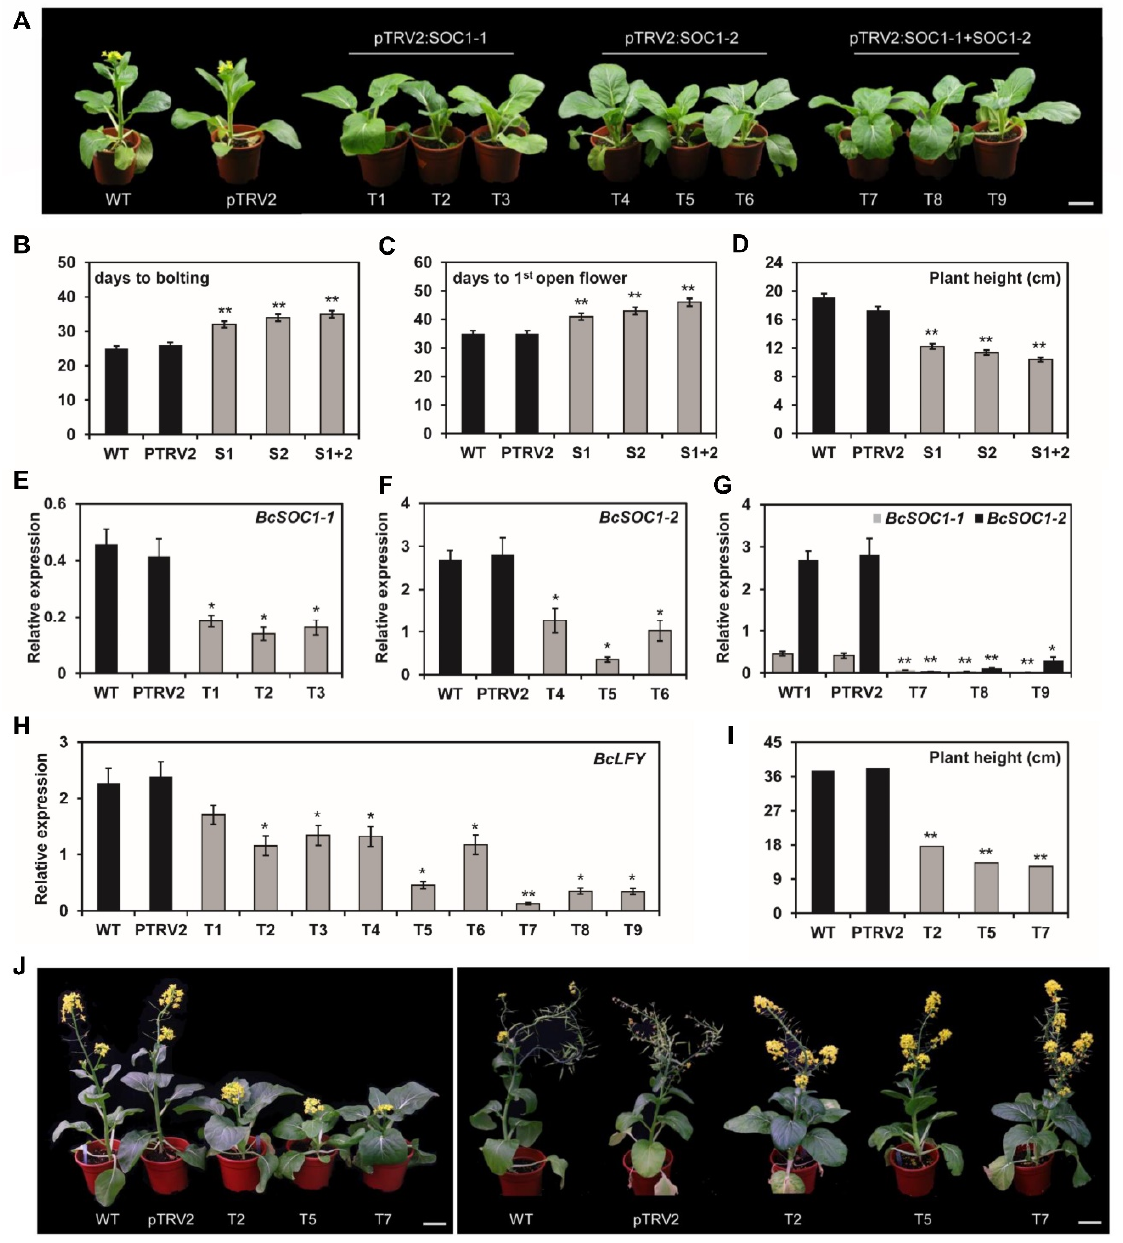
Figure 4. Knockdown of BcSOC1 using virus ‐ induced gene silencing (VIGS) in flowering Chinese cabbage. ( A ) Silencing of BcSOC1 significantly delayed bolting in flowering Chinese cabbage. S1, S2, and S1+2 represent pTRV2: SOC1 ‐ 1 , SOC1 ‐ 2 , and SOC1 ‐ 1 + SOC1 ‐ 2 , respectively. ( B – D ) Quantification of delayed bolting phenotypes in BcSOC1 knockdown lines. S1, S2 and S1+2 represent averages of the corresponding single and double knockdown lines, respectively. ( E – H ) Expression of BcSOC1 ‐ 1 , BcSOC1 ‐ 2 , and BcLFY in different BcSOC1 knockdown lines. ( I , J ) Silencing of BcSOC1 inhibited stem elongation in flowering Chinese cabbage, and the plant height was significantly decreased. WT and pTRV2 as the control (CK). Error bars represent standard errors. Significant differences were determined using Student’s t ‐ test (* represents p < 0.05 and ** represents p < 0.01). Bar = 5 cm.